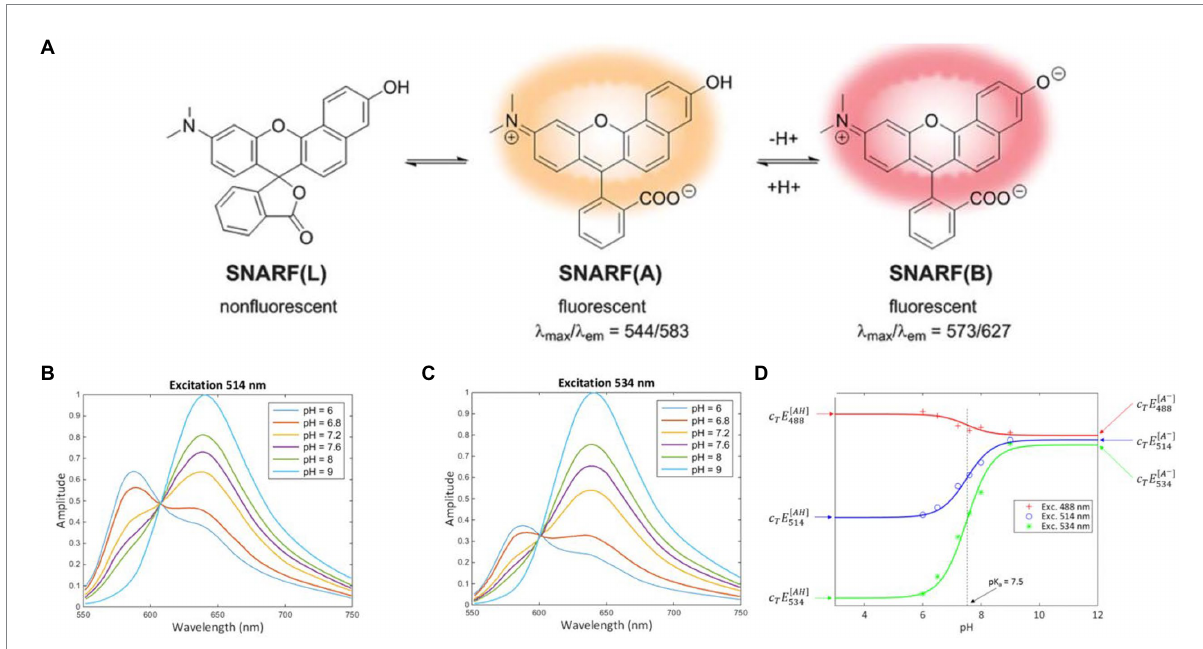
FIGURE 5 Fluorescent pH indicator dye sensing mechanism. (A) pH-dependent molecular equilibria structures of pH indicator dye SNARF derivative (SNARF- OH; Nakata et al., 2014). (B) Fluorescence emission spectra of C-SNARF-1 (5-(and-6)-Carboxy SNARF®-1) at 514 nm (Kateklum et al., 2018). (C) Emission spectra of C-SNARF-1 at 534 nm (Kateklum et al., 2018). (D) Mathematical modeling of C-SNARF-1 emission wavelength as a function of pH (Kateklum et al., 2018). These figures were reproduced with permission from Nakata et al. (2014) and Kateklum et al.